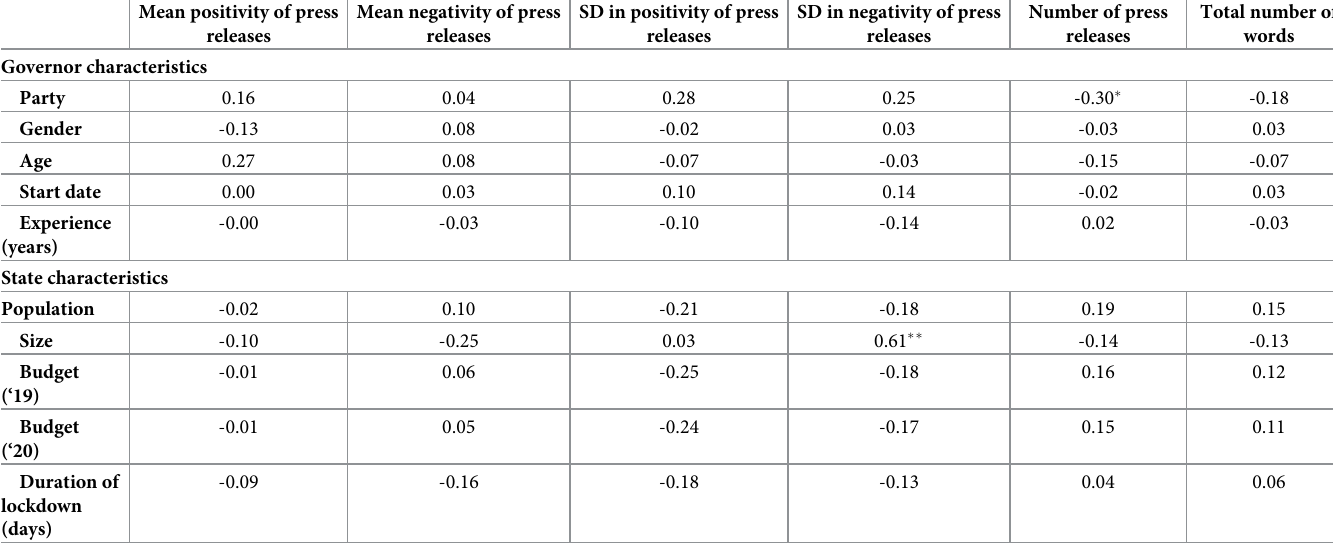
Table 2. Result of correlation analysis between frequency/sentiment of press releases and governor/state